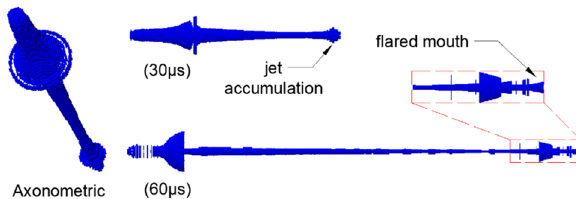
Figure 7. 3D results under the Euler algorithm.